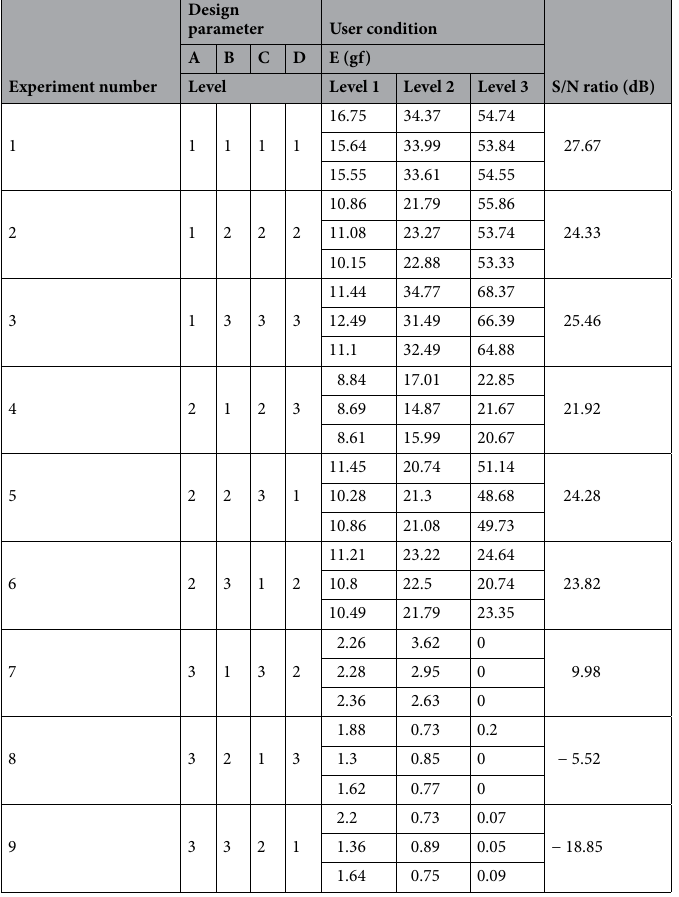
4 Table 2. L 9 ( 3 ) Taguchi orthogonal array and experimental